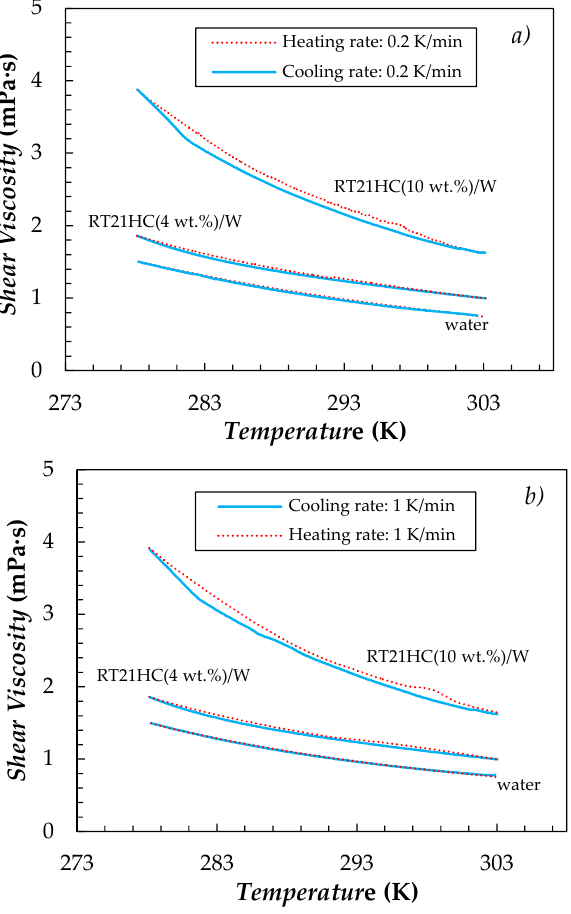
Figure 4. Shear viscosity–temperature curves obtained for water as well as 4 wt.% and 10 wt.% RT21HC/Water emulsions at scanning rates of ( a ) 0.2 and ( b ) 1 K/min.